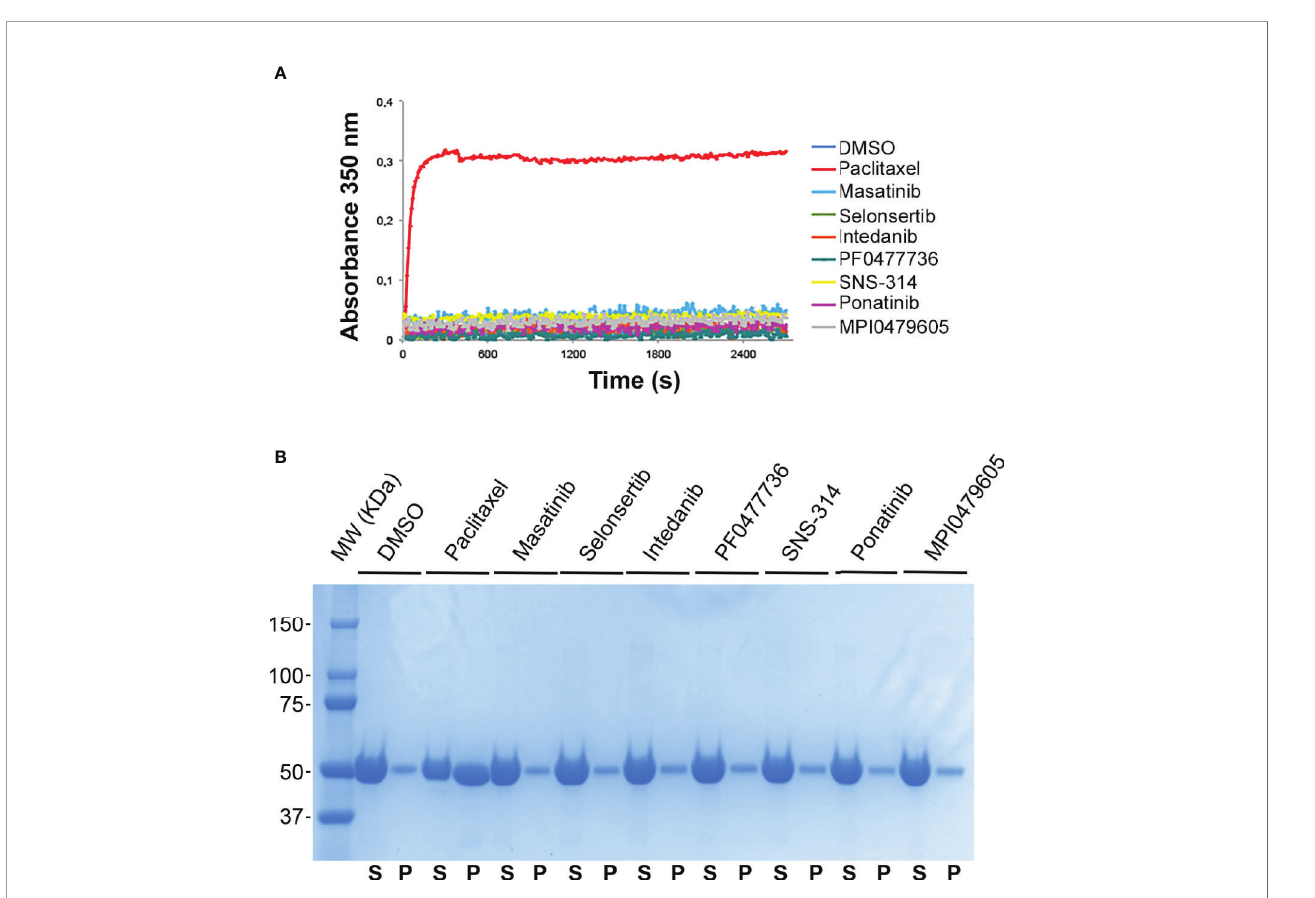
FIGURE 5 | Effect of the kinase inhibitors on microtubule assembly in vitro . (A) Kinase inhibitors do not promote tubulin polymerization. Time course of polymerization of puri fi ed tubulin (10 µM in BRB80 buffer with 1 mM GTP, 37°C) in the presence of vehicle (DMSO, blue line), paclitaxel (10 µM, red line), and the different kinase inhibitors (10 µM), as indicated, measured by turbidimetry at 350 nm. (B) Kinase inhibitors do not protect MTs from cold-induced depolymerization. Pre-polymerized MTs were incubated in the presence of 10 µM of kinase inhibitors, 10 µM paclitaxel or DMSO for 30 min at 37°C and then incubated at 4°C for 30 min. Free depolymerized tubulin (supernatant, S) and MTs (pellet, P) were separated by centrifugation on a sucrose cushion, as described in the Materials and Methods section. Equal volumes of the S and P fractions were subjected to SDS-PAGE separation and proteins were stained by coomassie